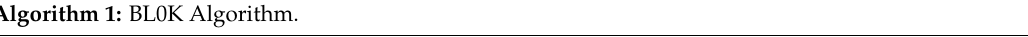
Algorithm 1: BL0K